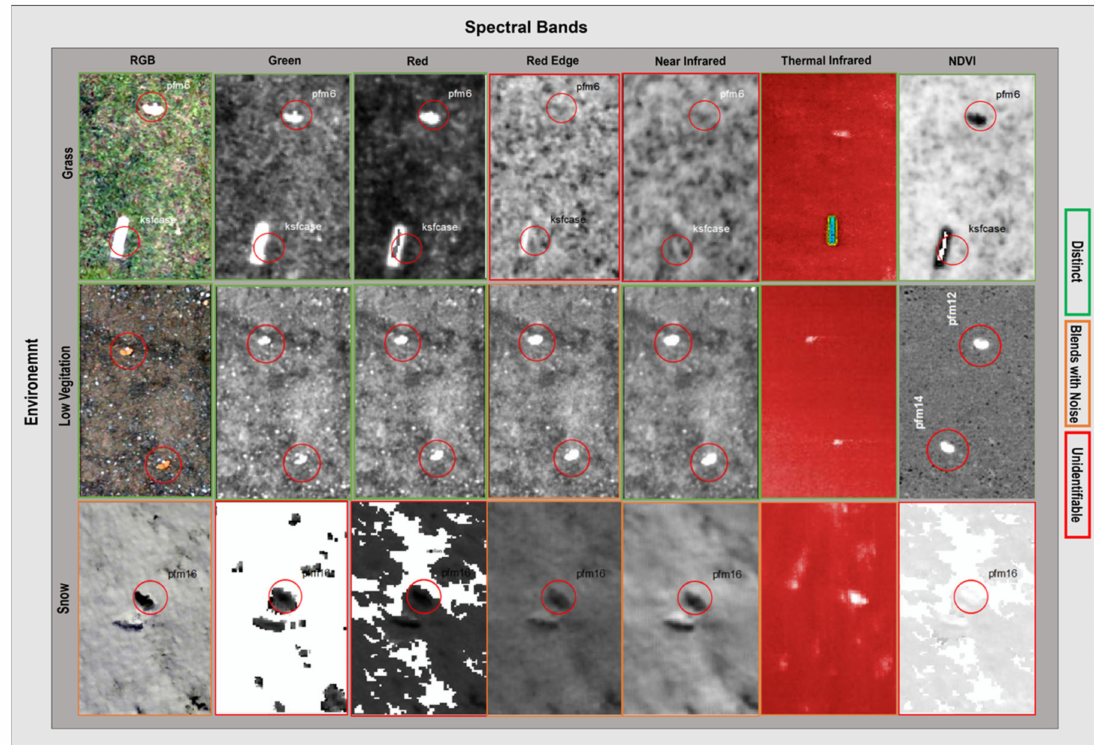
Figure 9. Clipped images of orthophotos from six di ff erent bandwidths (plus normalized di ff erence vegetation index), showing the success in identifying the plastic PFM-1 landmine and the aluminum KSF casing from the surrounding environment in grass, low vegetation and snow